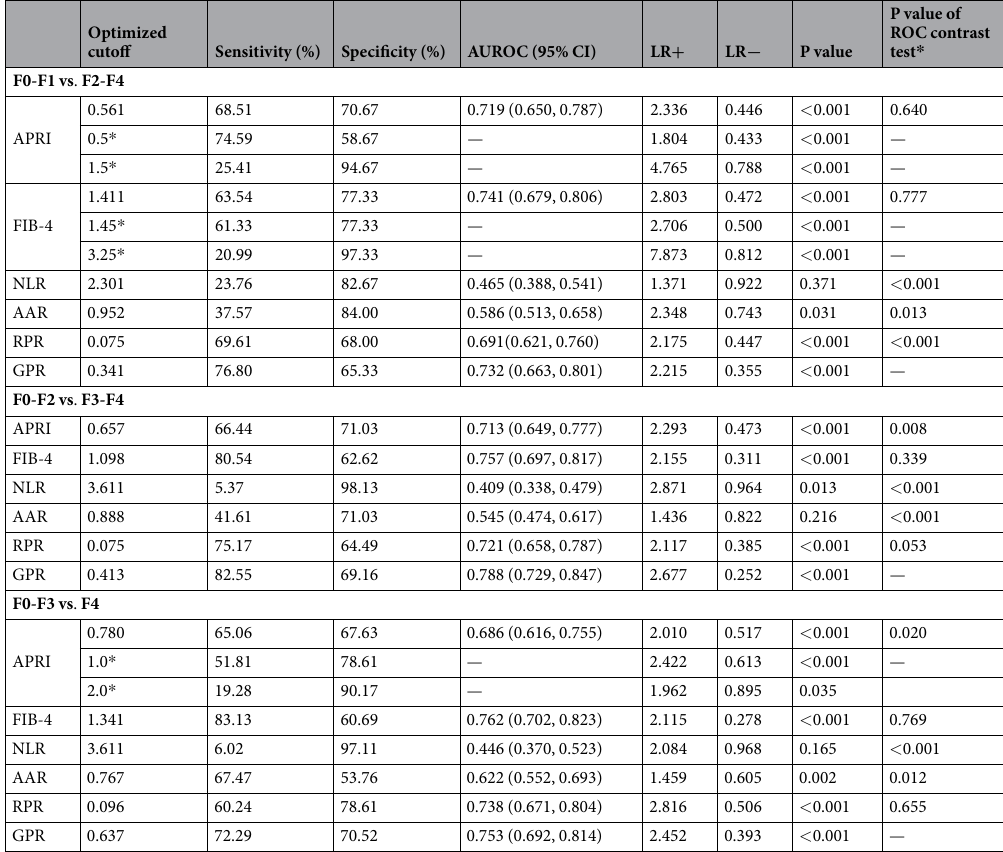
Table 2. Diagnostic accuracy of different indexes for the prediction of liver fibrosis in CHB patients. * Compared with GPR. AUROC, area under the receiver operating characteristic curve; CI, confidence interval; LR − , negative likelihood ratio; LR + , positive likelihood ratio; AAR, aspartate aminotransferase/alanine aminotransferase ratio; APRI, aspartate aminotransferase-to-platelet ratio index; FIB-4, fibrosis index based on the four factors; GPR, gamma-glutamyl transpeptidase to platelet ratio; NLR, neutrophil-to-lymphocyte ratio; RPR, red cell distribution width-to-platelet ratio. * threshold recommended by the WHO 12 .